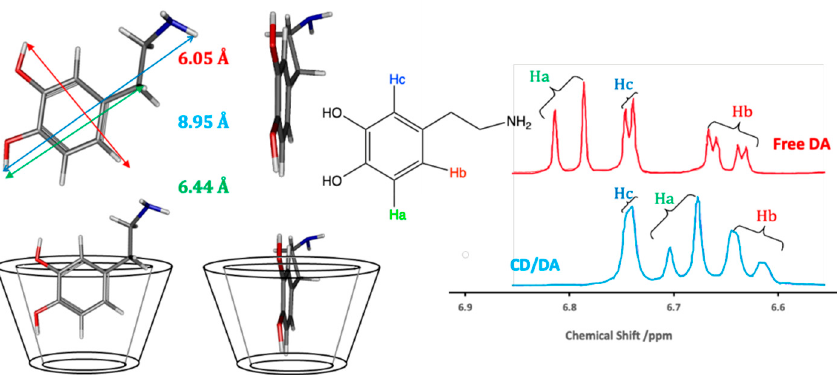
Figure 2. Schematic of the formation of an inclusion complex between β -CD and dopamine and the corresponding 1 H NMR data, with an excess of the β -CD.